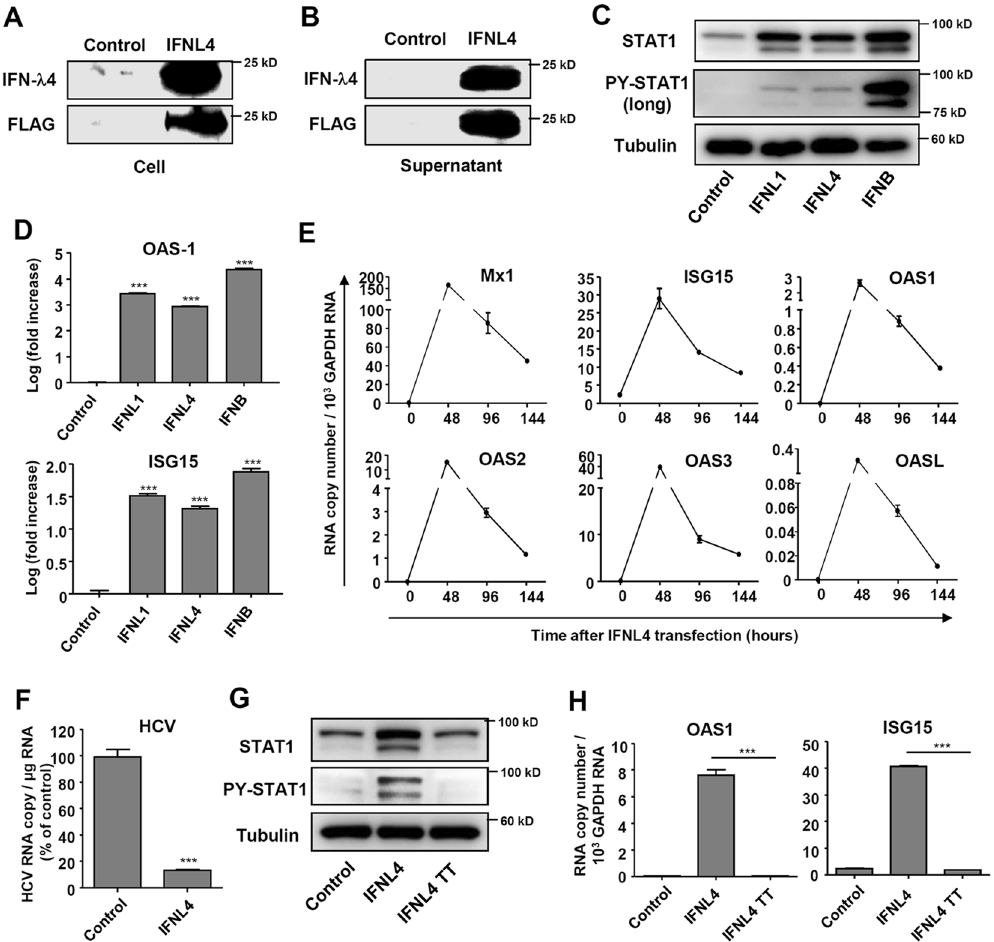
Figure 3. IFN- λ 4 overexpression induces ISG expression. ( A , B ) Huh-7 cells were transfected with control or IFN- λ 4-expressing plasmids. After 72 hours, the cell lysates ( A ) and culture supernatants ( B ) were harvested, and protein expression were analysed by immunoblotting. For the culture supernatants, immunoprecipitation with anti-FLAG-conjugated beads were used to pull down the FLAG-tagged IFN- λ 4 protein. The data are representative of two independent experiments. ( C , D ) Huh-7 cells were transfected with control, IFN- λ 1-, IFN- λ 4-, or IFN- β -expressing plasmids. After 96 hours, the cells were harvested, and protein expression or gene expression were analysed by immunoblotting ( C ) or real-time qPCR ( D ). ( E ) Huh-7 cells were transfected with IFN- λ 4-expressing plasmids. The cells were harvested at the indicated time points, and gene expression was analysed by real-time qPCR. ( F ) Huh-7 cells were infected with JFH1 HCVcc at 0.5 MOI followed by transfection with control or IFN- λ 4-expressing plasmids. After 72 hours, the cells were harvested, and HCV RNA titer was analysed by real-time qPCR. ( G , H ) Huh-7 cells were transfected with control, IFN- λ 4-, or IFN- λ 4 TT-encoding plasmids. After 96 hours, the cells were harvested, and protein and gene expression were analysed by immunoblotting ( G ) or real-time qPCR ( H ). In ( D , E , F , H ) data are presented as means ± S.E.M. *** P ≤ 0.001 (Student’s t-test). All the data are representative of two independent experiments. Full-length blots of PY-STAT1 ( C ) with multiple exposure times are included in the Supplementary Fig.